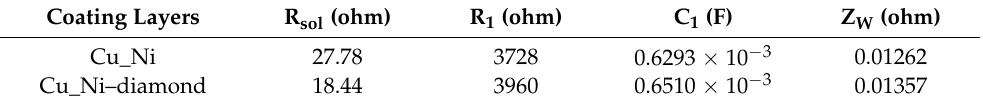
Figure 10. The fitting results of EIS tests ( a ) and the equivalent circuit ( b ). Table 2. The impedance value of the equivalent circuits.